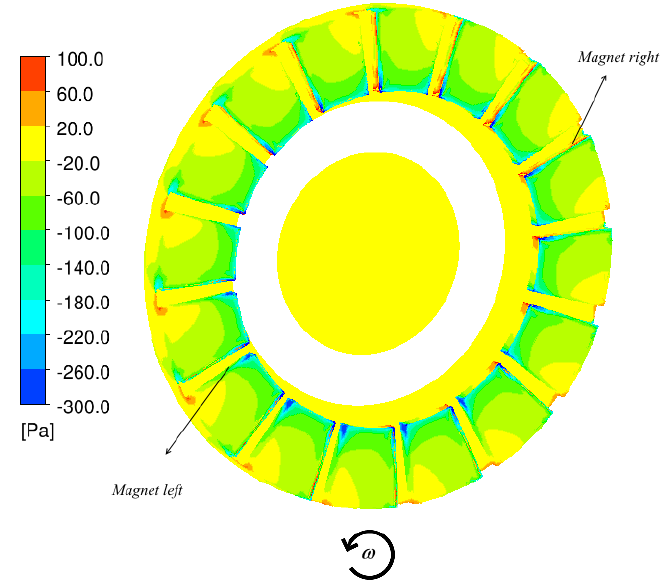
Figure 7. Static pressure contour on the rotor disk and the magnet at G = 0.0135, Re = 1.06 × 10 5 , α m = 0.8 and L =